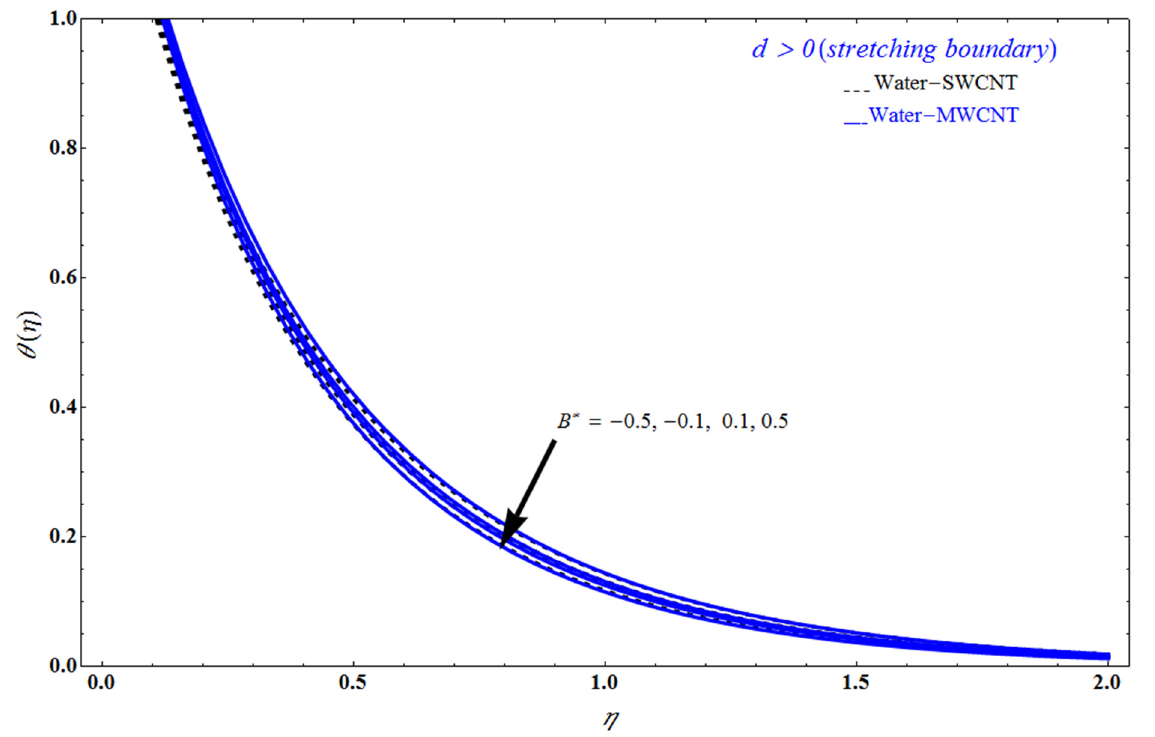
( ) θ η ( ) θ η versus similarity variable versus similarity variable